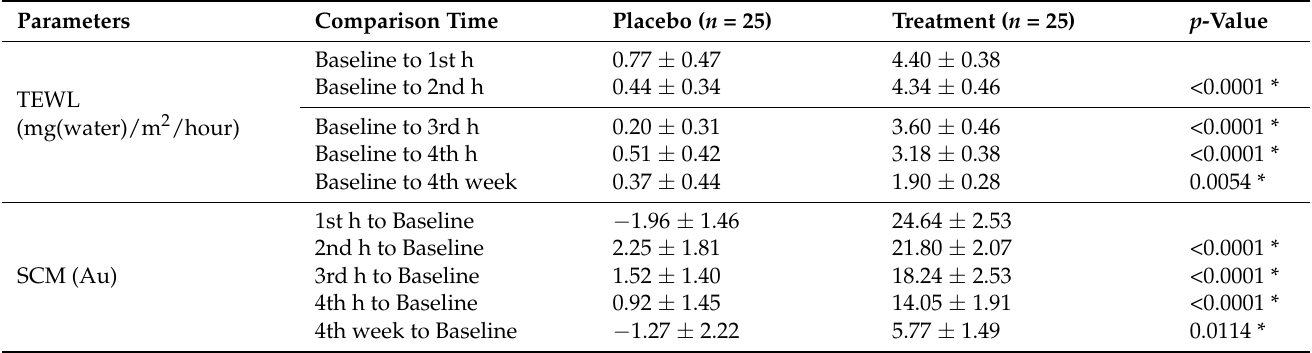
Table 3. The comparison of the changes in the studied parameters between the groups at different times is expressed as the mean difference.